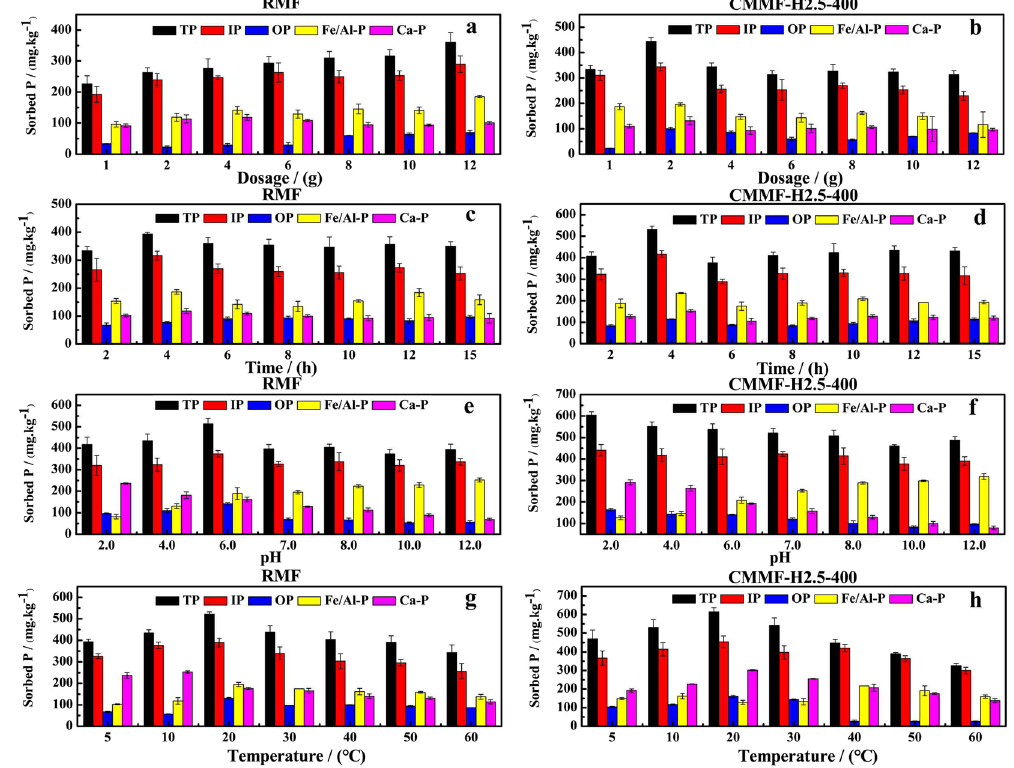
Figure 5. Effects of ( a , b ) dosage ( c , d ) time ( e , f ) pH and ( g , h ) temperature to the adsorption of sediment P in all